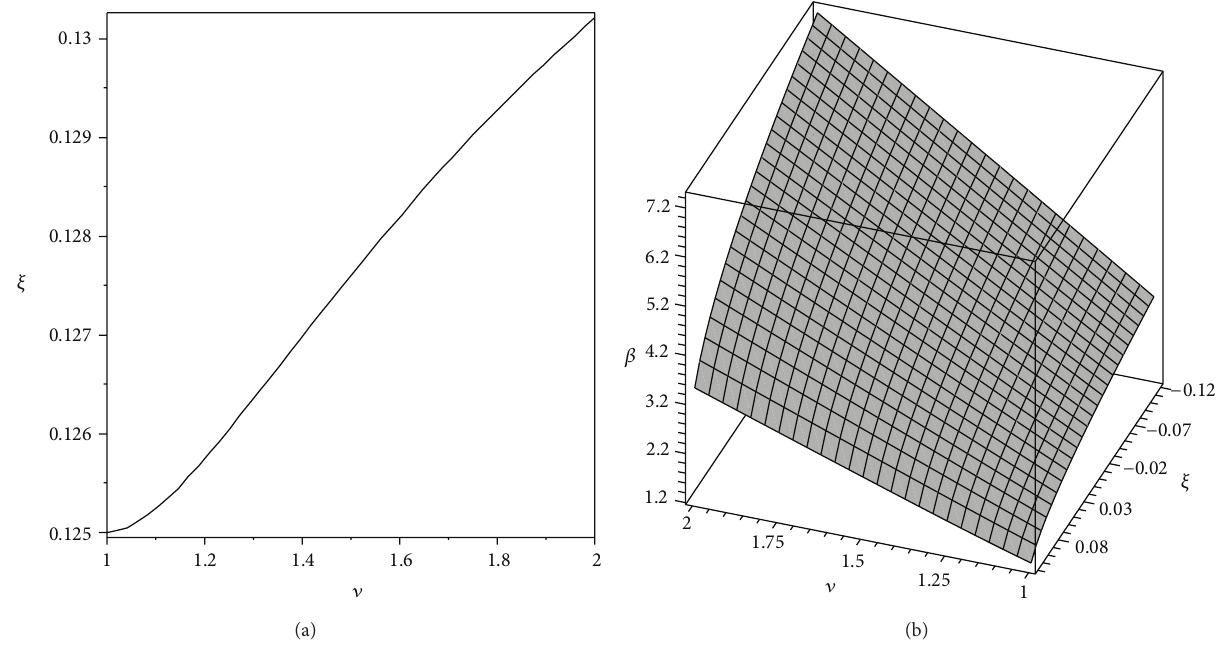
Figure 2: Variation of 𝜉 with respect to ] with (29) (a) and variation of 𝛽 with respect to ] and 𝜉 with (28) by sign +, for sign − in (28) 𝛽 has negative value. We choose special range of parameter 𝜉 with (29) in (b) figure.